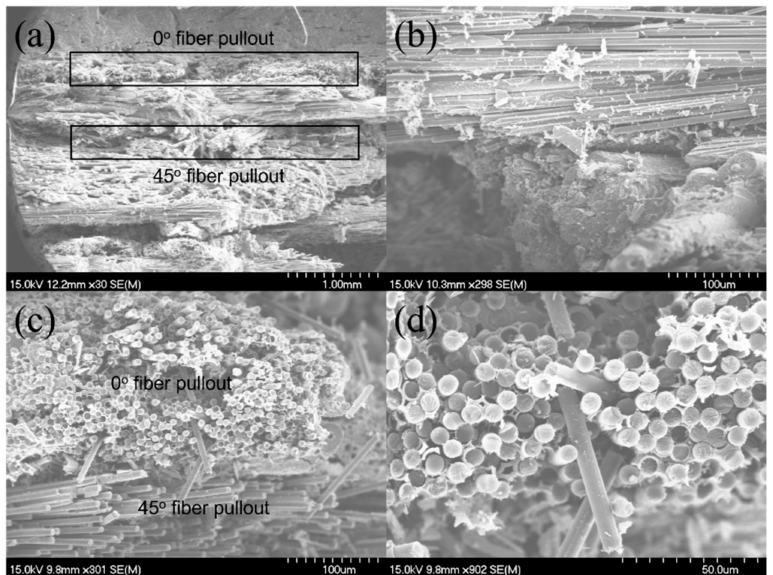
Figure 4. Tensile fracture surface of the 12k T-700 TM MWK–N–C/SiC specimen observed under SEM.